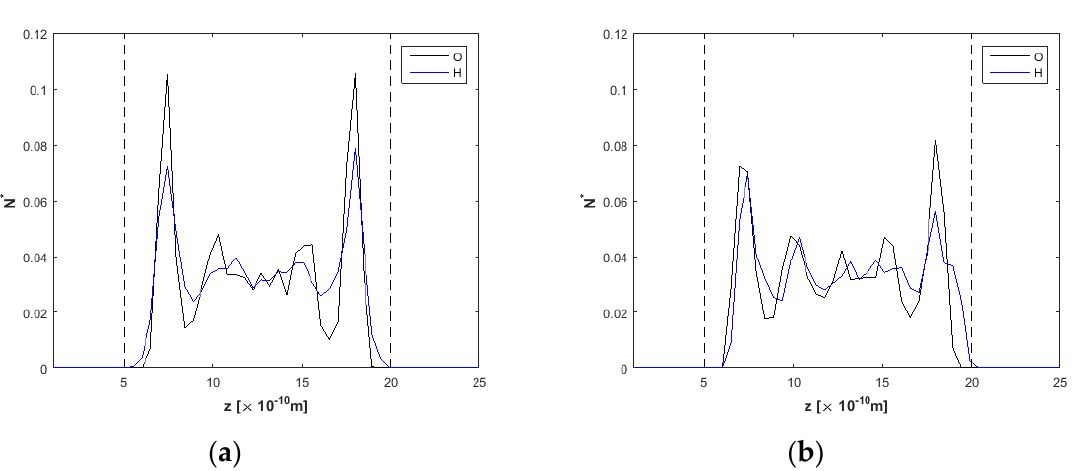
Figure 3. Density profiles for O and H, F ext = 0.025 kcal/molÅ and h = 1.5 nm, ( a ) at t = 5 ns, E = 0.0 V/Å and ( b ) t = 20 ns, E = 2.0 V/Å . Dashed lines denote wall limits.